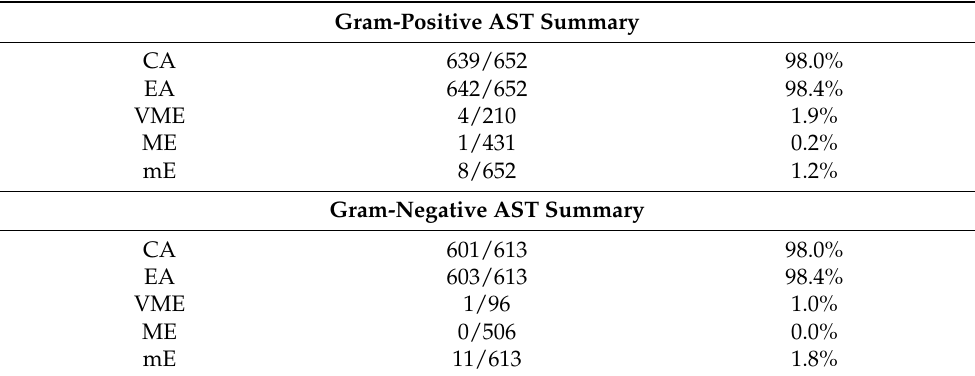
Table 3. LC vs. standard workflow for AST using VITEK 2: summary of results for Gram-positive and Gram-negative